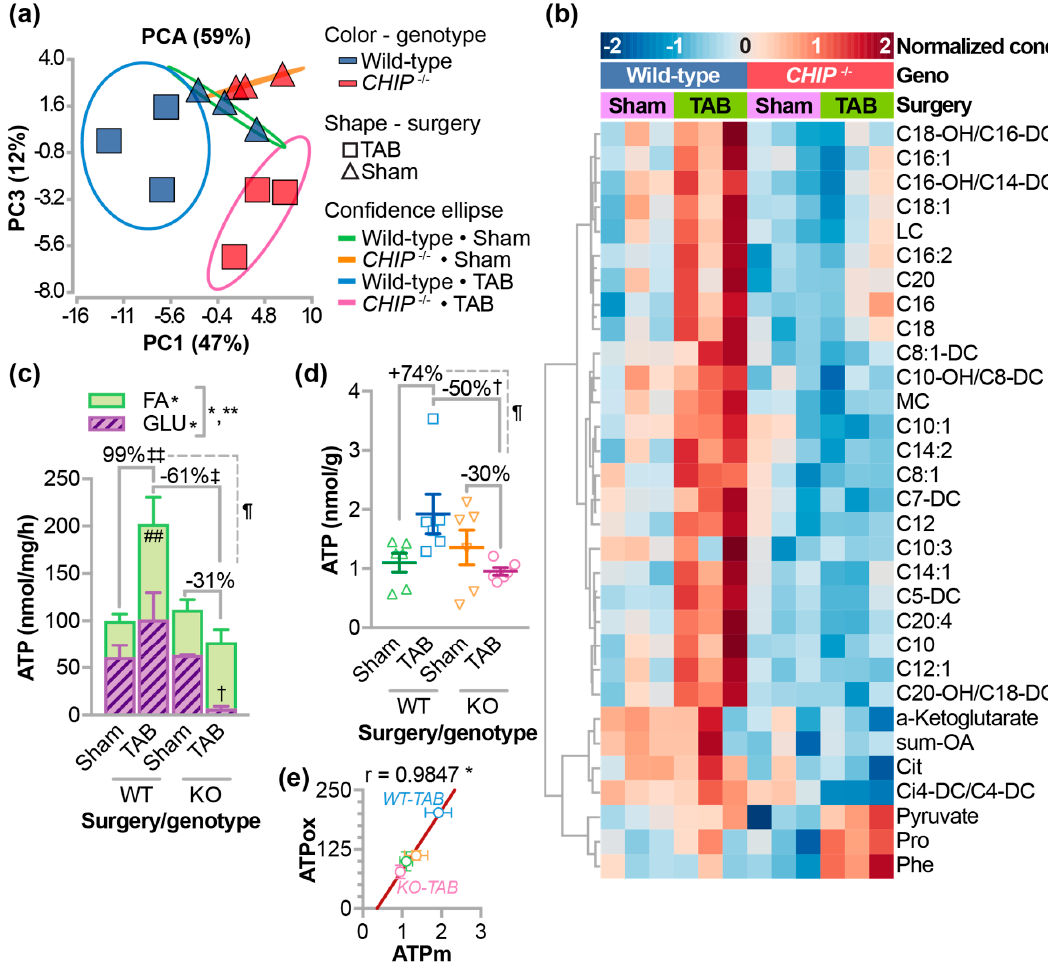
Figure 1. The effects of pressure overload on metabolism in CHIP − / − hearts. Metabolomic analysis of whole hearts isolated from wild-type or CHIP − / − mice one week after a sham surgery or trans-aortic banding (TAB) were analyzed using ( a ) principal component analysis (PCA) and ( b ) two-way ANOVA, N = 3 hearts per genotype per condition. Variances captured by the first and third principal components (PC) are shown. Differential metabolites via ANOVA (FDR < 10%) were clustered and represented by a heatmap. ( c ) Ex-vivo oxidative ATP generation rates in mouse heart homogenates summarized by the mean ± SEM using either fatty acid (open bars) or glucose (hashed bars) as a substrate. Two-way ANOVA for glucose oxidation, N = 3 hearts per genotype per condition: * p < 0.05 of genotype main effect and interaction between genotype and surgery, post-test: † p < 0.05 glucose oxidation in wild-type vs. CHIP − / − after one week of TAB. Two-way ANOVA for fatty acid oxidation, * p < 0.05 on surgery main effect. Two-way ANOVA for total ATP, * p < 0.05 on surgery main effect, ** p < 0.01 on genotype main effect and interaction, post-test: ‡‡ p < 0.01 total ATP in wild-type sham vs. TAB mice, post-test, ‡ p < 0.05 total ATP in wild-type vs. CHIP − / − after one week of TAB and the surgery-dependent percent change in ATP production rates (TAB vs. sham) in wild-type vs. CHIP − / − was significant at p = 0.039. ( d ) Steady-state ATP levels in mouse hearts represented by dot plot and summarized by the mean ± SEM, N = 6 hearts per genotype, per condition. Two-way ANOVA interaction of the main effects p = 0.0177, post-test: † p < 0.05 in wild-type vs. CHIP − / − at one week of TAB and the surgery-dependent percent change in ATP levels (TAB vs. sham) in wild-type vs. CHIP − / − was significant at p = 0.034. ( e ) Pearson correlation analysis of ATP determined by ex vivo oxidization rates (ATPox) or measured steady-state ATP levels (ATPm) * p = 0.0153.